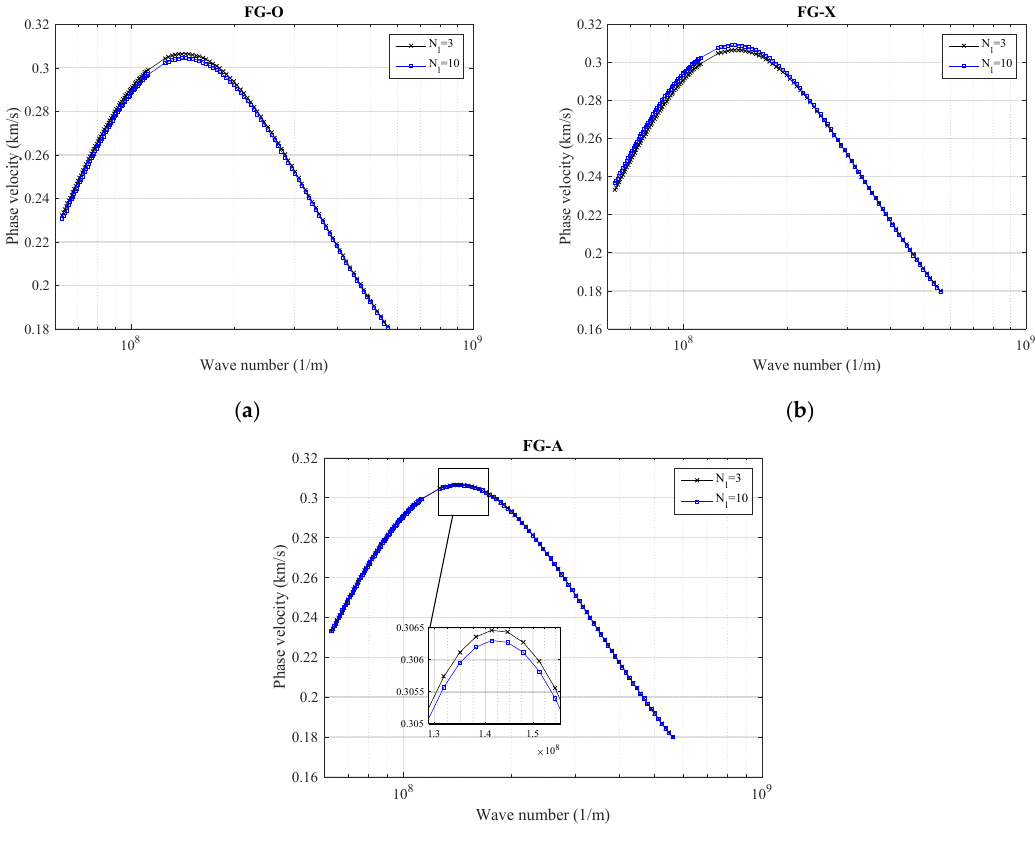
Figure 5. The variation of phase velocity versus number of layers in GNPs for ( a ) FG-O, ( b ) FG-X, and ( c ) FG-A patterns of GNPs ( α = π /4, ℓ = 1 nm, μ = 10 nm, g * GNP = 1%) .